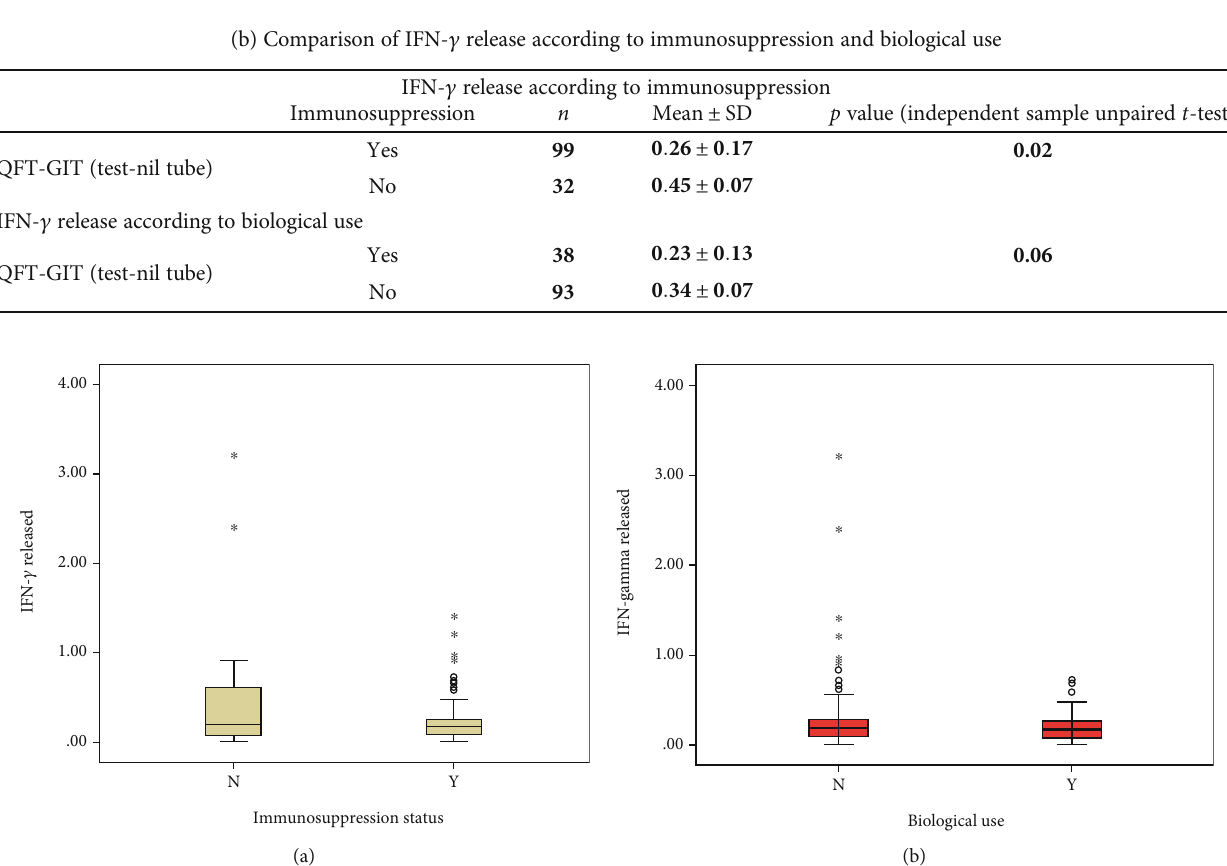
Figure 4: (a) Box plot comparing IFN- γ release according to immunosuppression. (b) Comparison of IFN- γ release according to biological use.